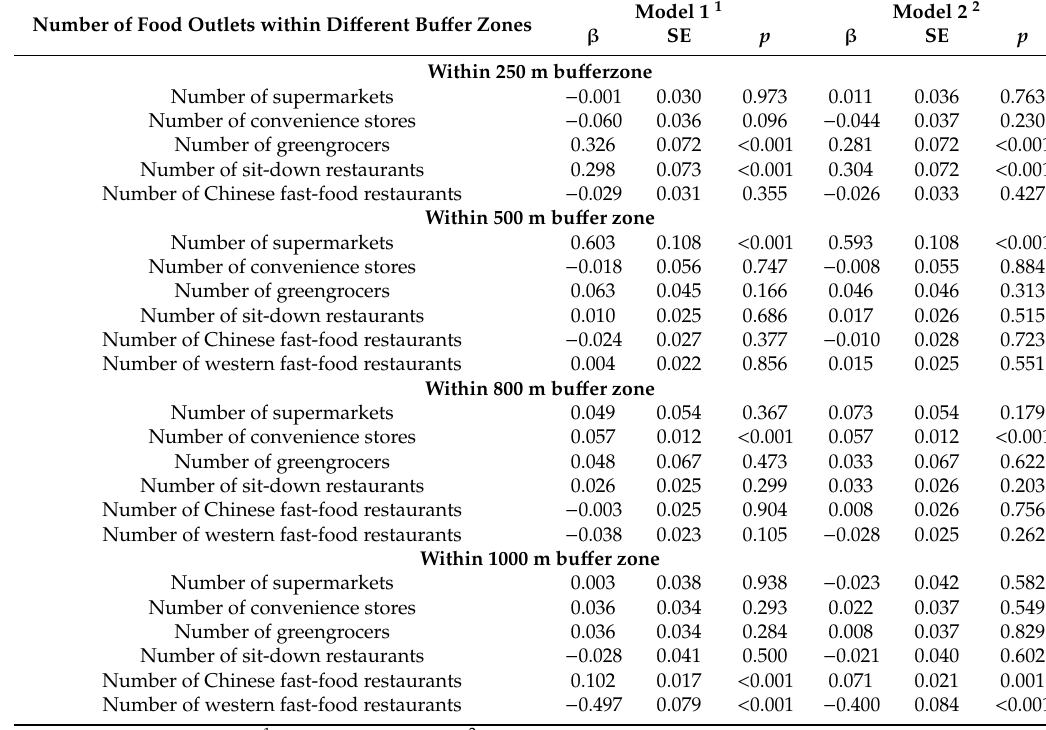
Table 4. Associations between the density of food outlets and body mass